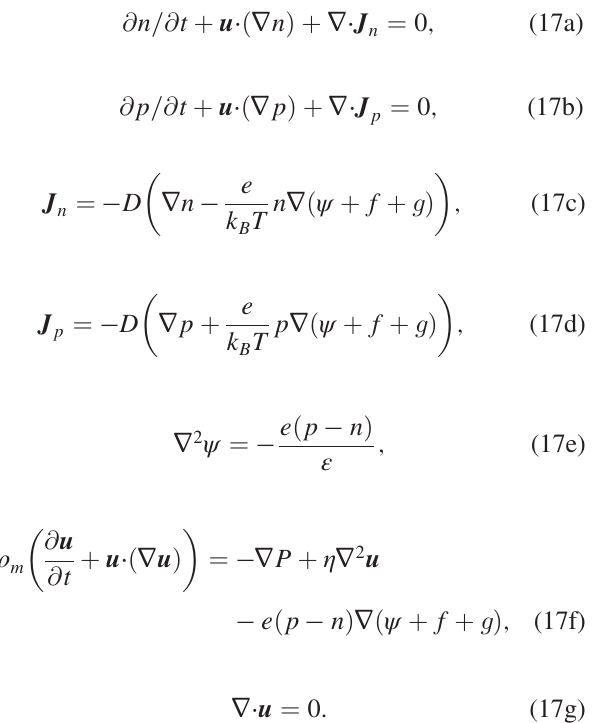
calculation, l ¼ AB ¼ CD ¼ BC = 2 ¼ 0 : 72 μ m. In refer-